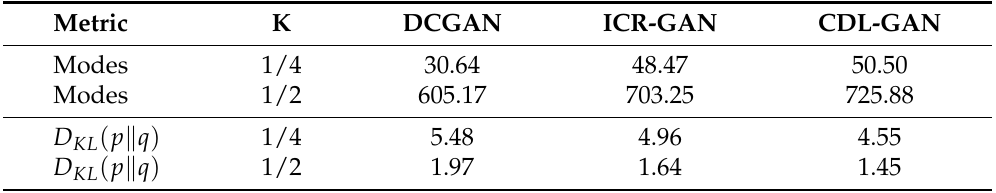
Figure 8. Image samples from different models on CelebA-HD dataset. Table 3. Number of modes (higher is better) recovered by the generator on the Stacked MNIST